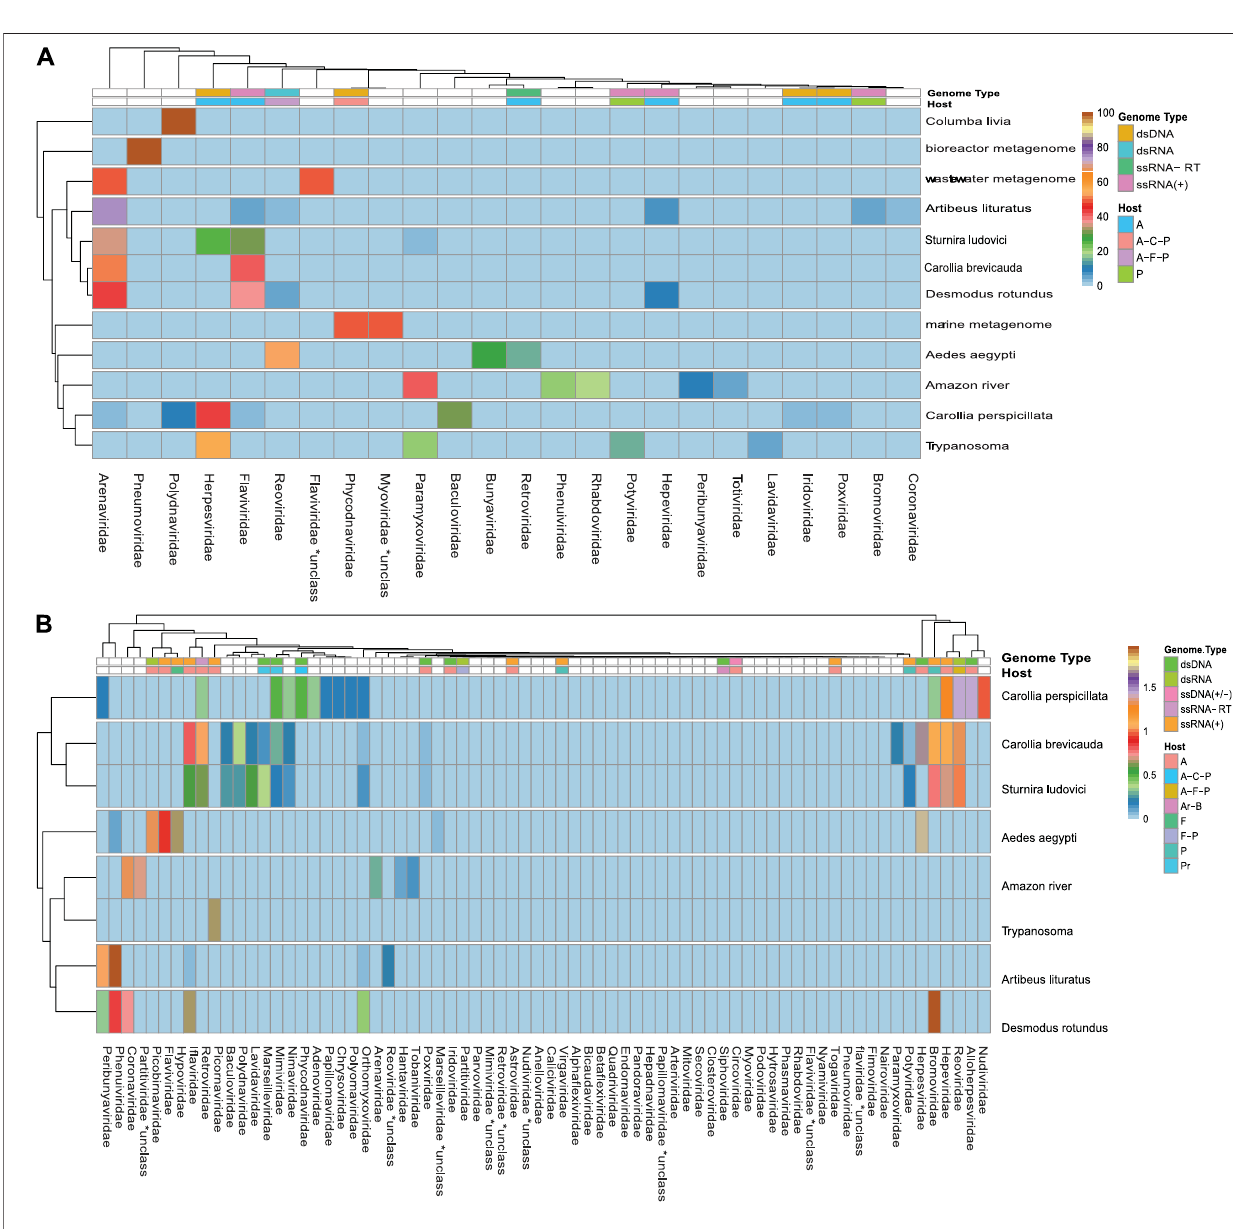
Frontiers in Genetics |